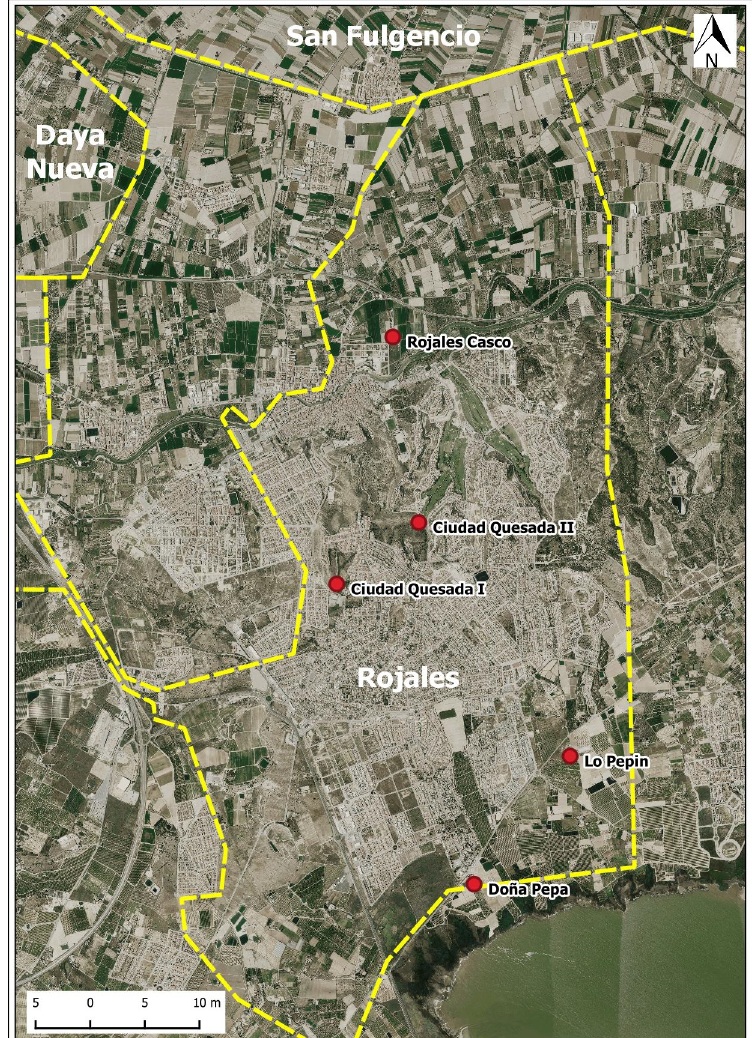
Figure 2. Location of the treatment plants in Rojales. Source: Instituto Cartográfico Valenciano (ICV). Own elaboration.